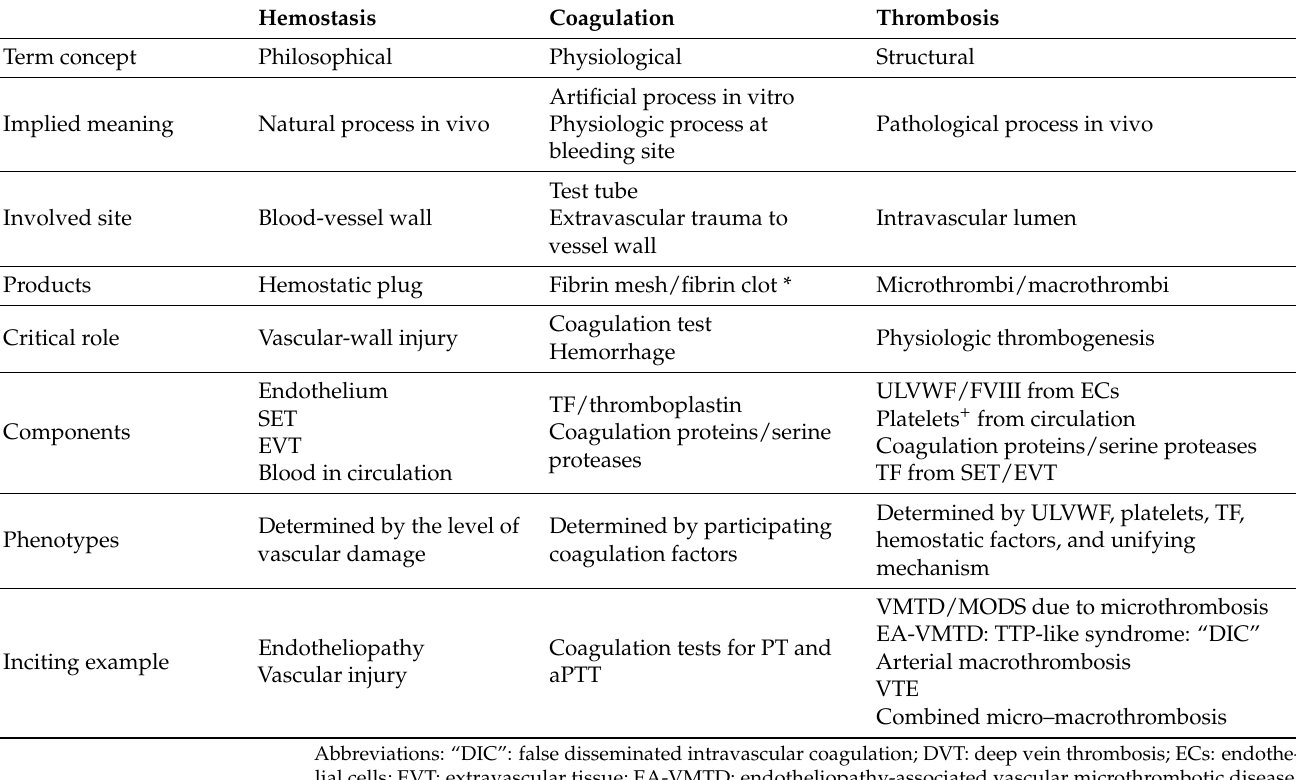
Table 1. Conceptual understanding of the terms: hemostasis, coagulation, and thrombosis. Hemostasis Coagulation